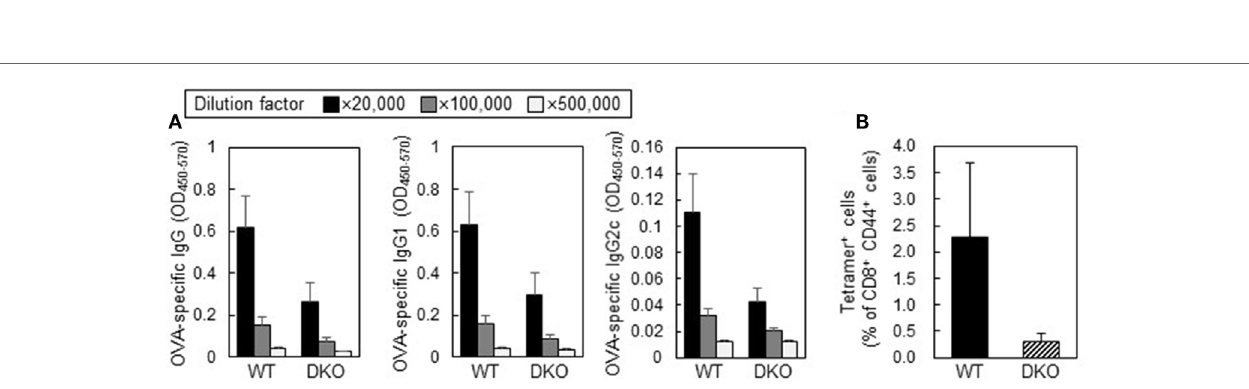
FigUre 6 | Vaccine adjuvant effect of carbonate apatite (CA)-cytosine-phosphate-guanine (CpG) against influenza virus. Mice were immunized subcutaneously at the base of the tail with SV alone or with SV plus CA nanoparticles that did not contain CpG oligodeoxynucleotides (ODNs), with SV plus K-type CpG ODNs (10 or 50 µg CpG/mouse), with SV plus CA-CpG (10 µg CpG/mouse), or with SV plus alum. (a,B) SV-specific antibody responses. Levels of SV-specific total IgG (a) , IgG1 (B) , and IgG2c (B) in plasma were evaluated by ELISA 7 days after the final immunization. (c) Hemagglutination inhibition (HI) assay. HI titers in plasma samples were evaluated 7 days after the final immunization. (D) Preventive effects against influenza virus. Fourteen days after the final immunization, mice were challenged with a 10-LD 50 dose of influenza virus A/PR/8 (H1N1). Body weights and survival rates were monitored for the next 14 days. The data in this figure suggest that CA-CpG acted as an influenza vaccine adjuvant in mice. n = 5 per group. Data are given as mean ± SEM. ** p < 0.01 vs. K-type CpG ODNs (10 µg CpG ODNs/mouse)-treated group as indicated by Dunnett’s